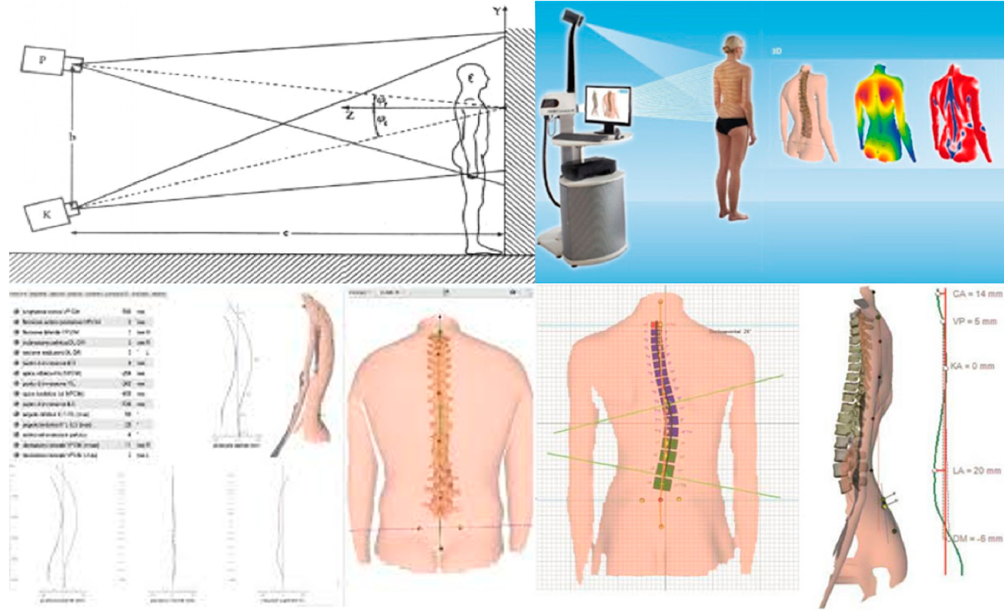
Figure 1. Rasterstereographic-system Formetric-4D.